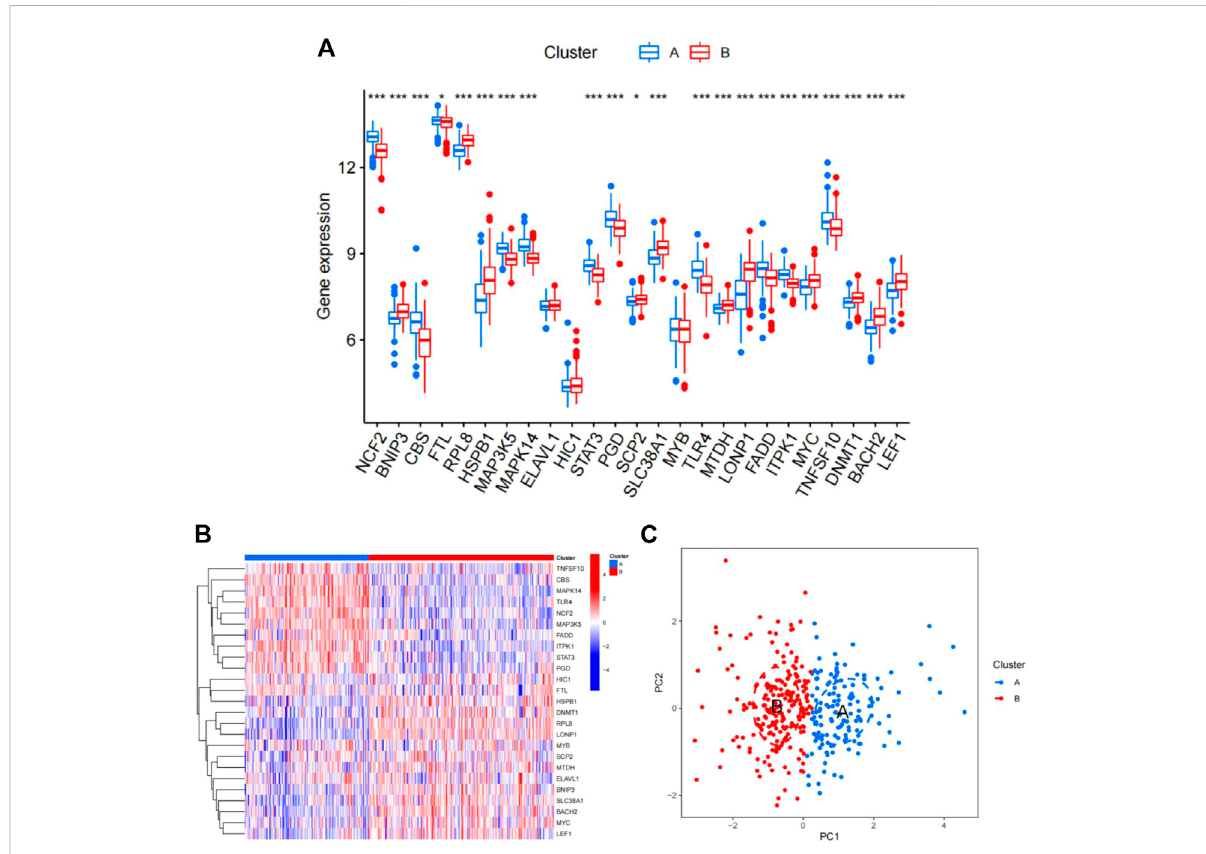
FIGURE 5 Differencesintheexpressionof25ferroptosis-andnecroptosis-relatedgenesinclusterAandclusterB. (A) Differentialexpressionhistogramof the 25 ferroptosis- and necroptosis-related genes in cluster A and cluster B. Red: cluster B; blue: cluster A. (B) Expression heat map of the 25ferroptosis-andnecroptosis-relatedgenesinclusterAandclusterB.Red:clusterB;blue:clusterA;red:highexpression;blue:lowexpression.